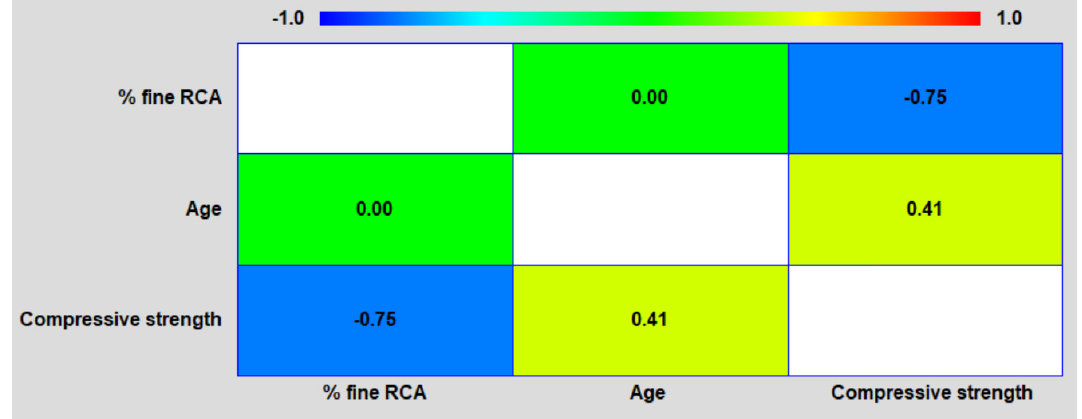
Figure 5. Pearson correlation matrix.